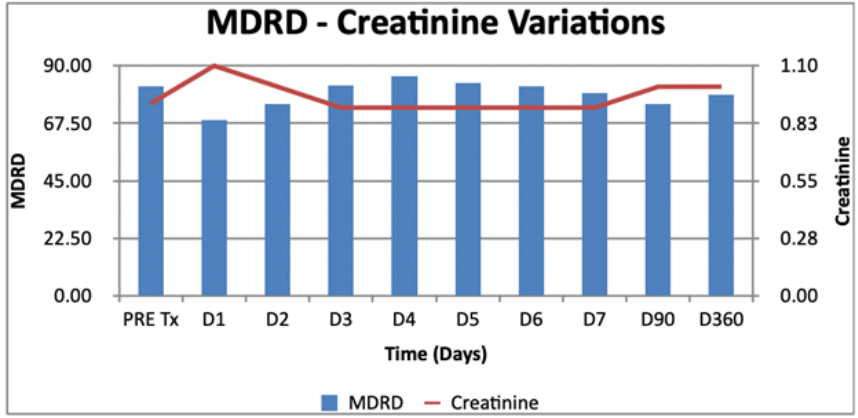
Figure 2. Evolution of creatinine and MDRD in the postoperative period. Table 4. Factors associated with changes in creatinine over follow-up. Estimate, confidence limits, and p -values are shown. MELD: Model for End-stage Liver Disease; PRBC: packed red blood cells; CRRT: continuous renal replacement